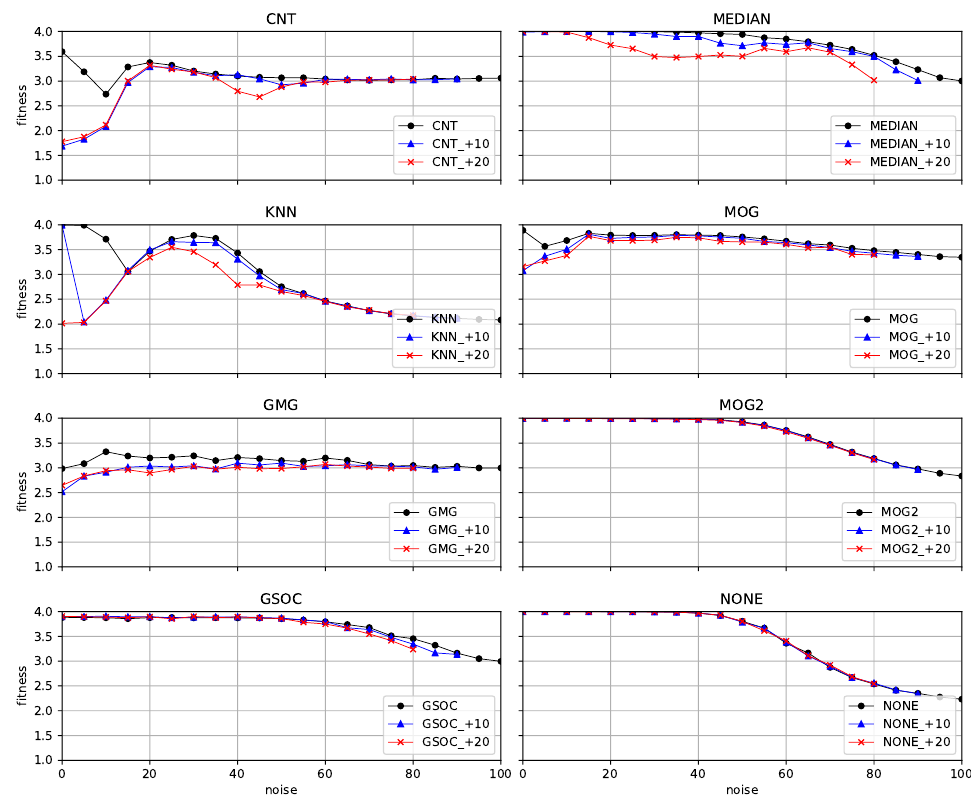
Figure 8. Monte Carlo analysis: best fitness of individuals (value noise 100 corresponds to std. dev. = 1 for Gaussian